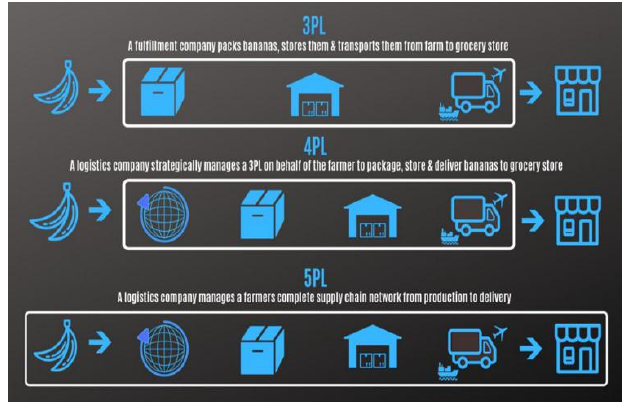
Figure 4: 5PL model